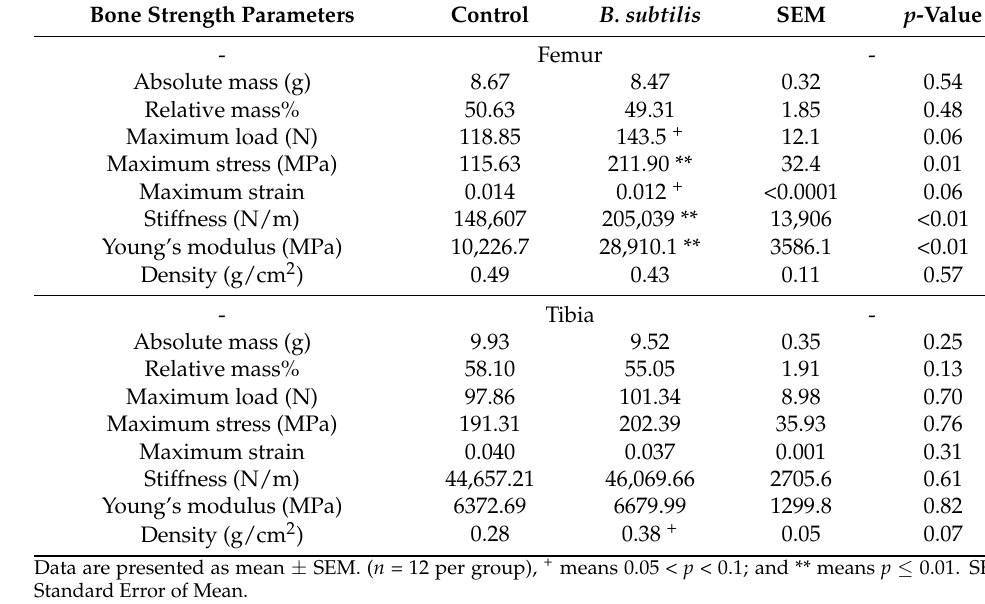
Table 5. Effects of Bacillus subtilis on the parameters of bone strength.